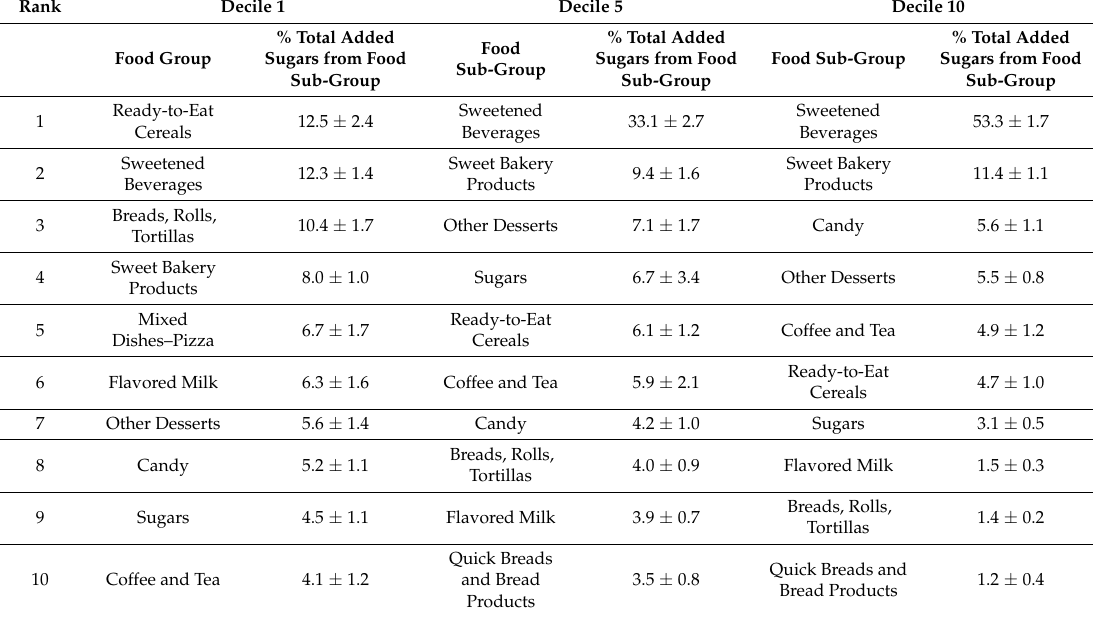
Table 4. Top ten food sources of added sugars for adolescents and teens 9–18 years by decile of intake, data from the National Health and Nutrition Survey, 2009–2012 ( n = 3238) 1